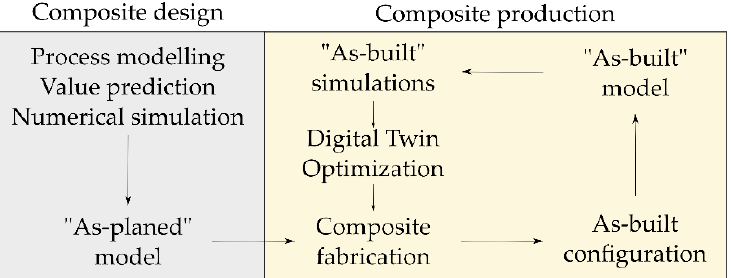
Figure 2. Schematic explanation of the as-planned and as-built configurations for composite mod- eling.